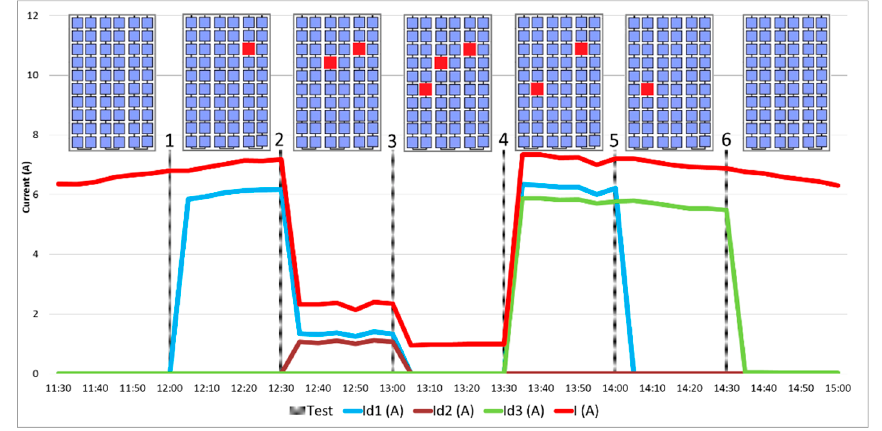
Figure 10. Total output PV module and bypass diode currents measured in test 3.